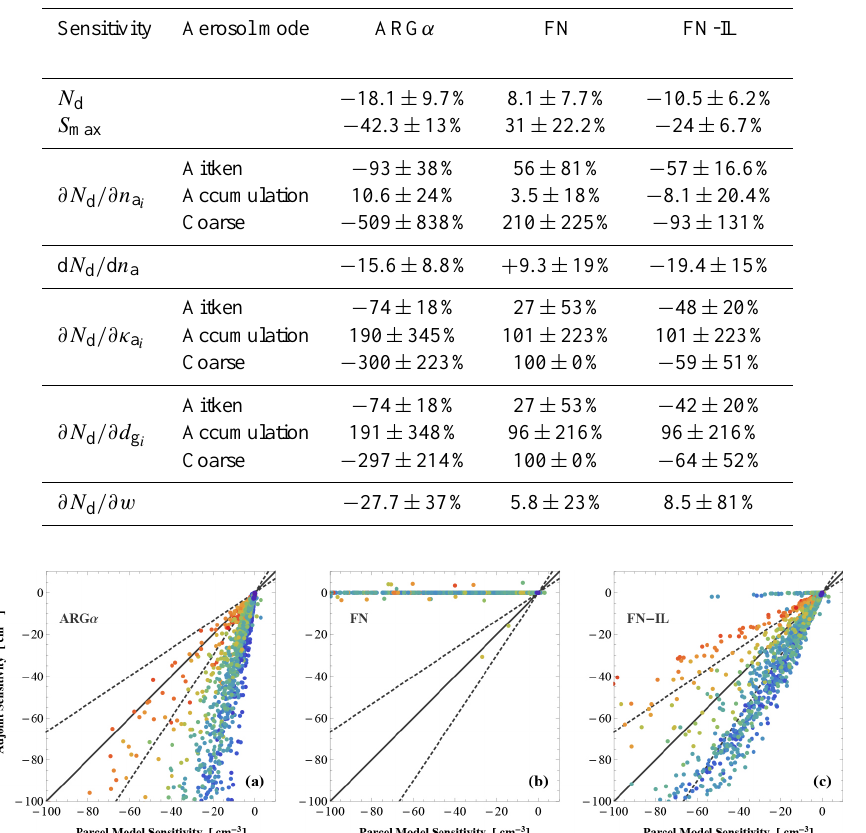
Table B1. Relative error for N d , s max , and the adjoint sensitivities ∂N d /∂χ j , computed with the adjoint of the activation parameterizations, as compared against numerical parcel model values. Reported values correspond to the mean and the standard deviation of the percent error.